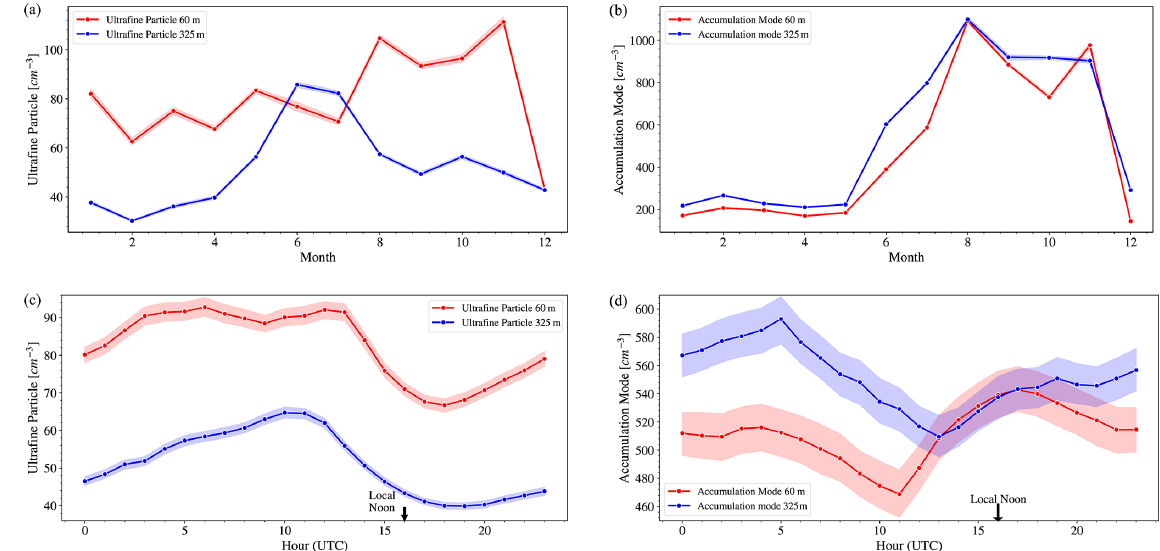
Figure 3. Seasonal and diurnal variation of the number concentration of ultrafine and accumulation mode particles: (a) monthly average of the ultrafine particles at 60 and 325m, (b) monthly average of the accumulation mode at 60 and 325m, (c) hourly average of ultrafine particles at 60 and 325m, (d) hourly average of accumulation mode at 60 and 325m. The shaded area corresponds to a confidence interval of 95%. Time is UTC; LST is UTC −